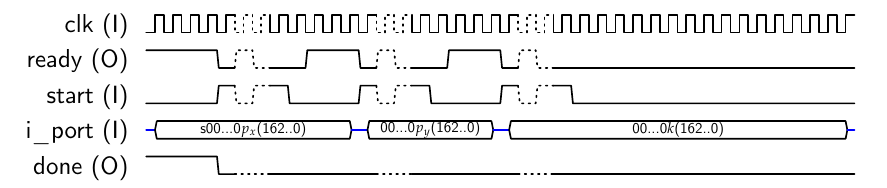
Figure 9. Sequence for loading p x input data.